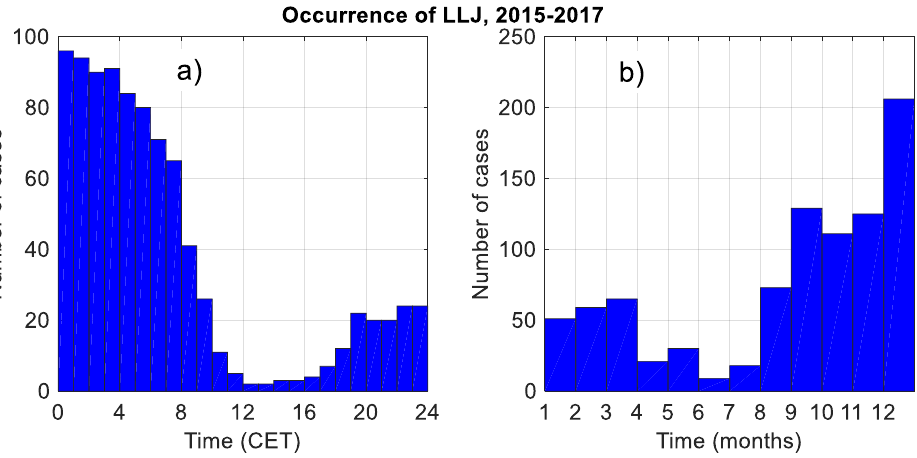
Figure 26. Diurnal ( a ) and annual ( b ) distributions of the number of LLJ events.